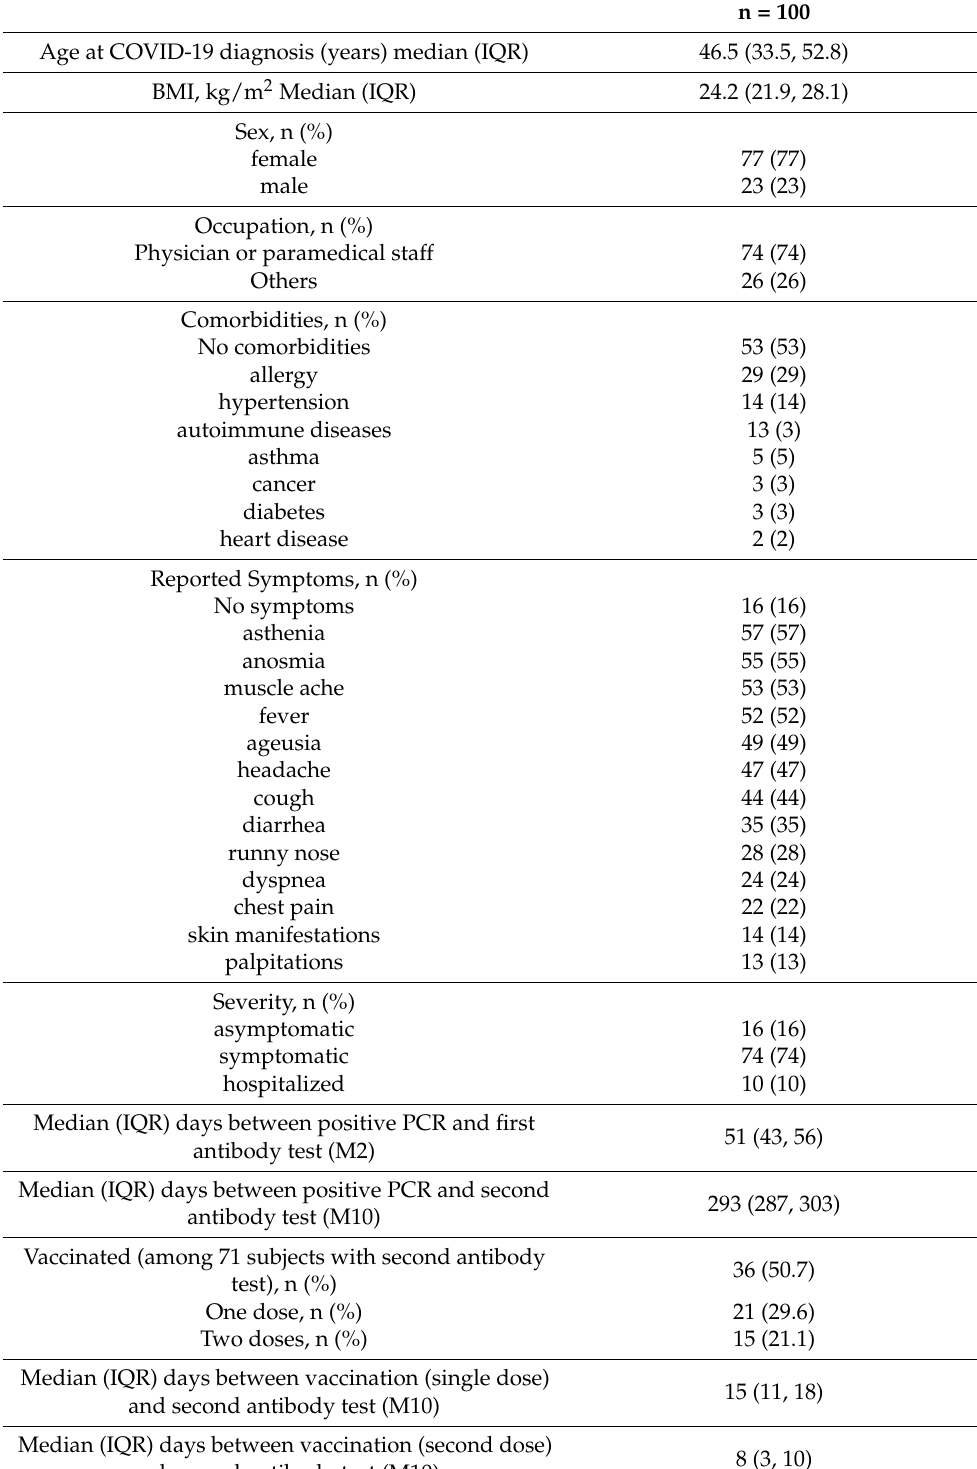
Table 1. Characteristics of the study population with SARS-CoV-2